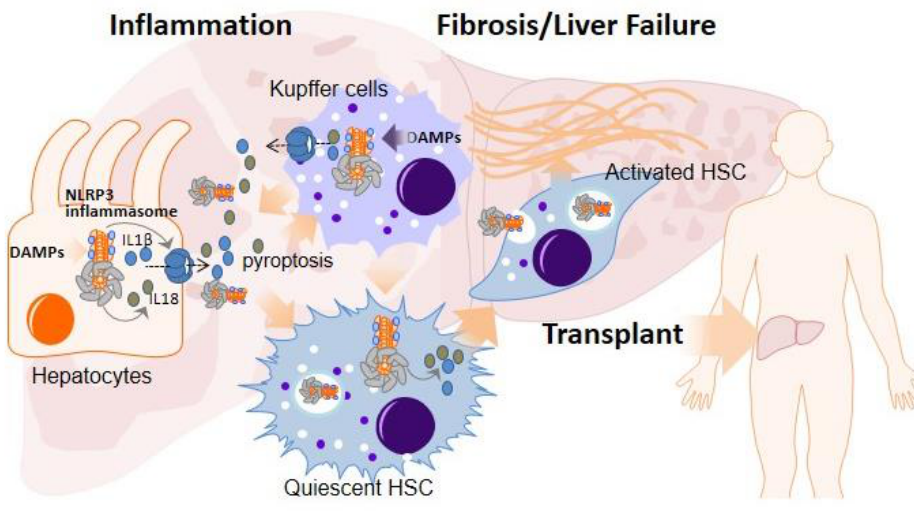
Figure 2. Activation of inflammasome/pyroptosis pathway in liver diseases. Activation of inflammasome in hepatocytes and KCs in early stages of inflammation associated to several liver diseases such as ALD, NAFLD or virus infection induce the release of a plethora of pro-inflammatory compounds, which will active HSCs and evoke an state of fibrosis which can degenerate to the end stage cirrhosis. This process can lead to liver transplantation as ultimate solution.